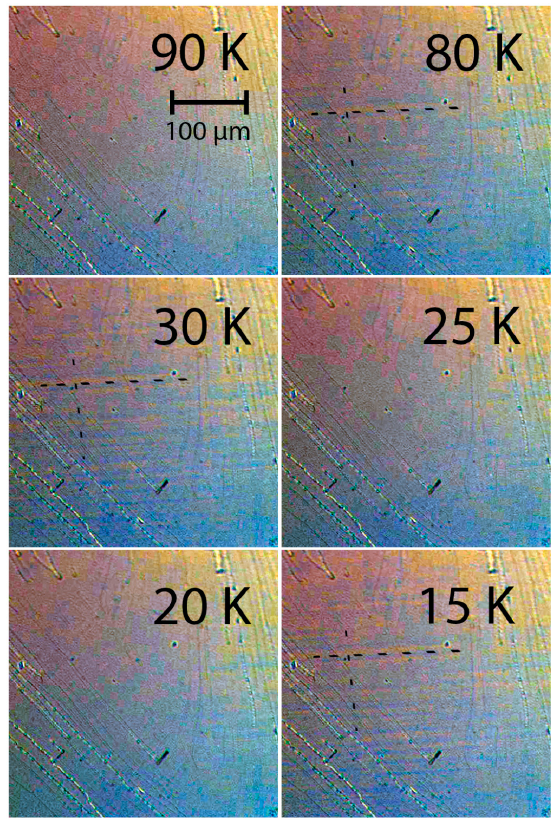
Figure 2. Temperature evolution of polarized optical images of the (Ba 1 − x K x )Fe 2 As 2 ( x = 0.24) single crystal. Scale bar corresponds to 100 μ m. The sequence shows the appearance of orthorhombic/magnetic domains at 80 K, highlighted with dashed lines to guide the eyes (horizontal lines in the center of the image panels). The domains are clearly visible on cooling down to 30 K, but disappear at 25 K. They reappear at 15 K. The scratch-like lines running at approximately 45° inclination in the left-bottom corner of the image panels correspond to growth terraces and faults.